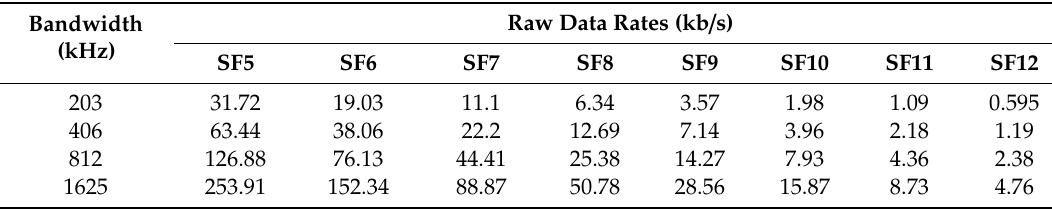
Table 1. SX1280 raw data rates with di ff erent spreading factors (SFs) and bandwidth.